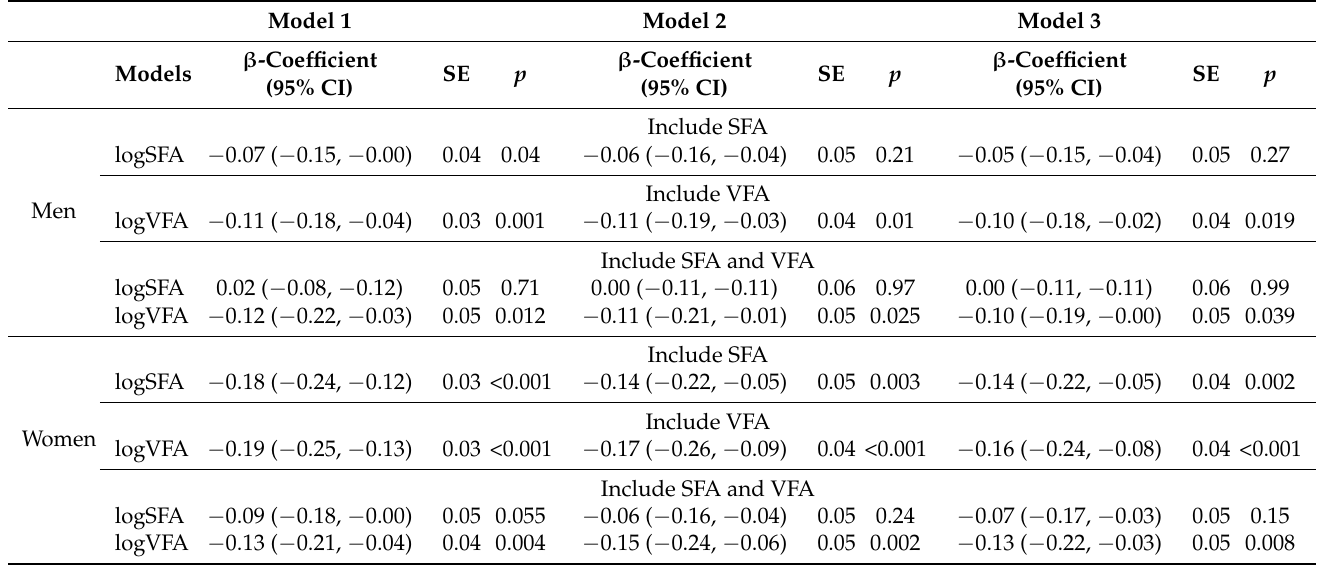
Table 3. Results of sex-specific multiple linear regression analyses between logSFA, logVFA, and